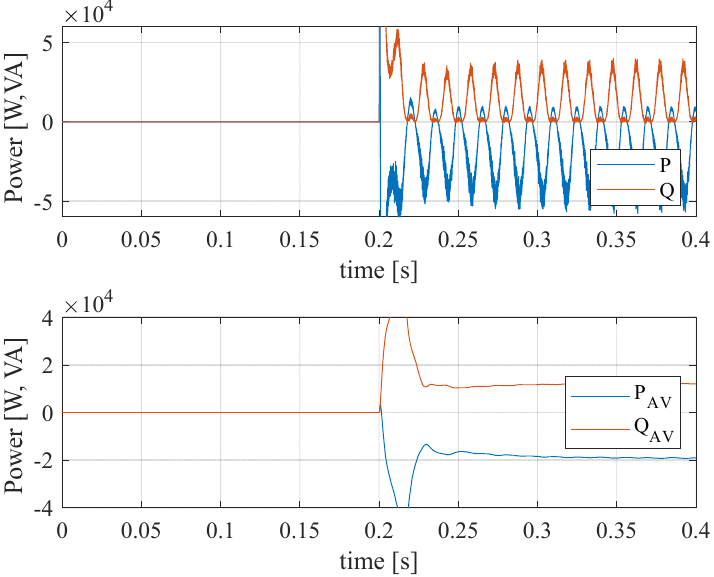
Figure 21. Active and reactive power when PMSM loaded ICE engine as the generator.